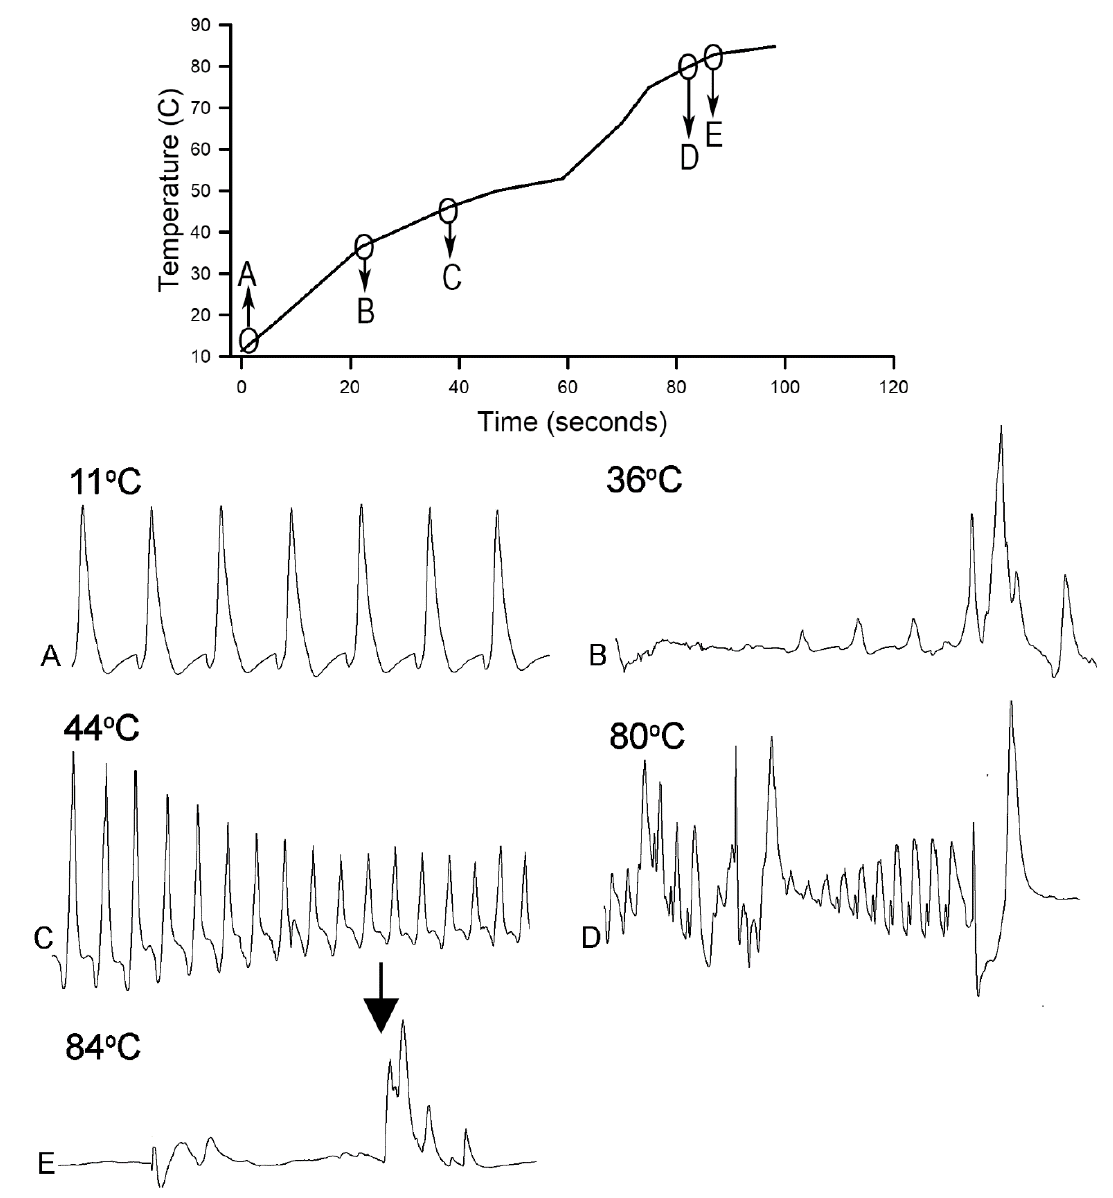
Figure 7. Heart rate measures at various temperatures while increasing from 10 ◦ C to 84 ◦ C in crayfish conditioned at 10 ◦ C for 24 h. The ECG traces are shown for crayfish after 24 h of being maintained at 10 ◦ C prior to the heating and during the heating at a rate of 46 ◦ C / min. The heart rhythm stopped at 80 ◦ C. The arrow shown in E represents artifacts from re-zeroing the impedance detector while recording. The sequence of events is in alphabetical order. Each trace is 10 s in duration.